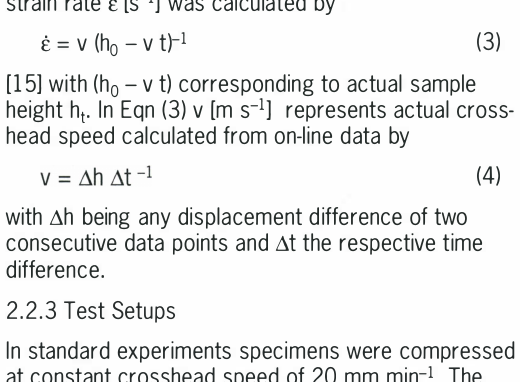
Fig. 3: Influence of test setup on basic relationships. A, constant speed experiment; B, constant strain rate